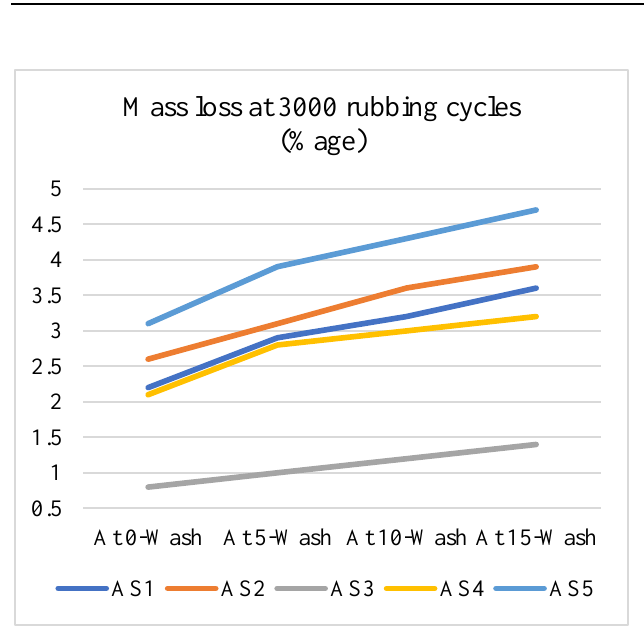
Fig. 2. Mass loss at 3000 rubbing cycles at various washing intervals